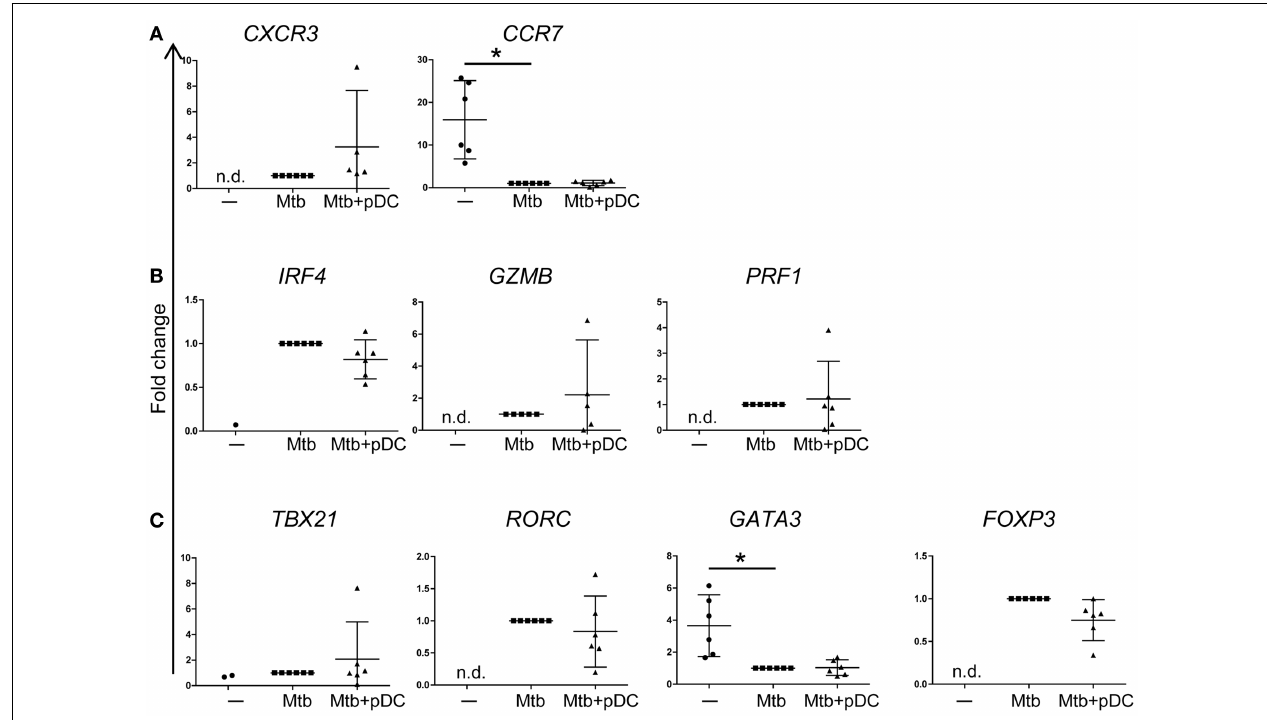
(2 − [( ∆ Ct)reference − ∆ Ct(value)] ) was calculated relative to ∆ Ct of CD4 + CD3 + CFSE low cells stimulated with Mtb-infected CD1c + DCs ( ∆ Ct reference ) since most of the transcripts were undetectable in unstimulated conditions ( − ). In unstimulated conditions ( − ), IRF4 andTbet transcripts were detectable only in one and two samples out of six, respectively. Mean ± 95% confidential interval of at least five donors in two independent experiments shown.Wilcoxon signed-rank test; * p < 0.05; n.d.,